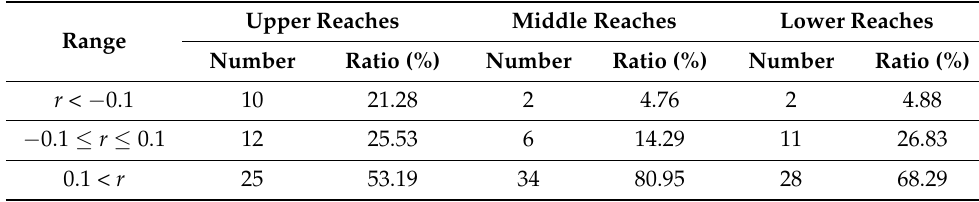
Table 5. Change rates ( r ) of urban density in 130 cities in the three reaches in YREB. Upper Reaches Middle Reaches Lower Reaches Range Number Ratio (%) Number Ratio (%) Number Ratio (%) r < − 0.1 4.88 − 0.1 ≤ r ≤